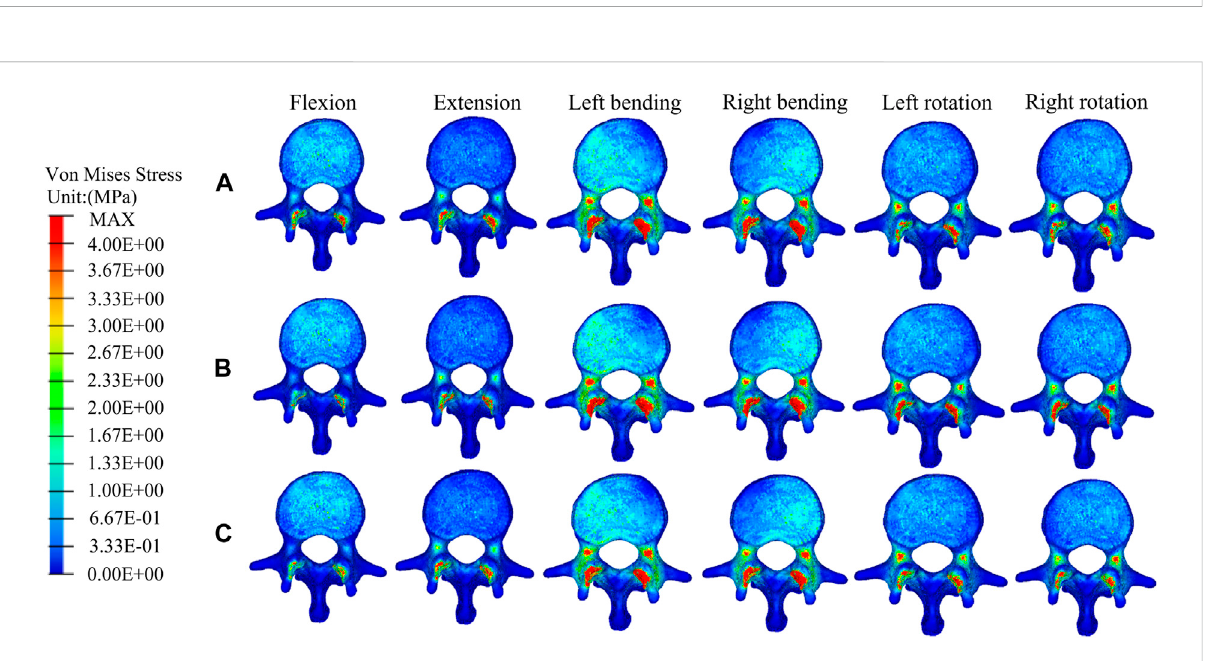
FIGURE 8 The distributions of the von Mises stress on L1. The distributions of the von Mises stress on L1 in a fractured model (A) , UPVP (B) , and BPVP (C) under fl exion, extension, left/right bending, and left/right